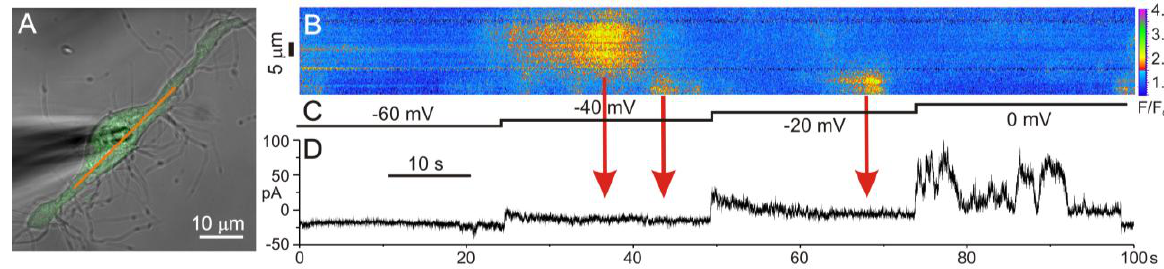
FIGURE 3. Loose/absent coupling of calcium release events and membrane currents in arterial ICs. (A) Transmitted light image of an arterial IC loaded with calcium-sensitive fluorescent indicator (green pseudocolour) and patched with a glass pipette. (B) Line scan image of normalised calcium fluorescence obtained by repeatedly scanning the orange line in panel A over 100 sec. X axis shows time, y axis shows the position on the scanned line. Fluorescence signal is colour-coded; pixels in yellow and red indicate elevated intracellular calcium concentration. (C) Voltage protocol imposed on the patched cell – its membrane was held at –60, –40, –20, and 0 mV, each step for 25 sec. (D) Membrane current of the patched cell, recorded simultaneously with calcium imaging. Small transient inward current can be seen at –60 mV and long-lasting transient outward current at 0 mV. Calcium release events in the cell did not elicit membrane current (red